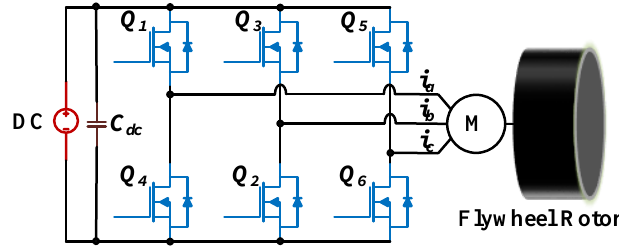
Figure 1. The topology of the PMSM drive of